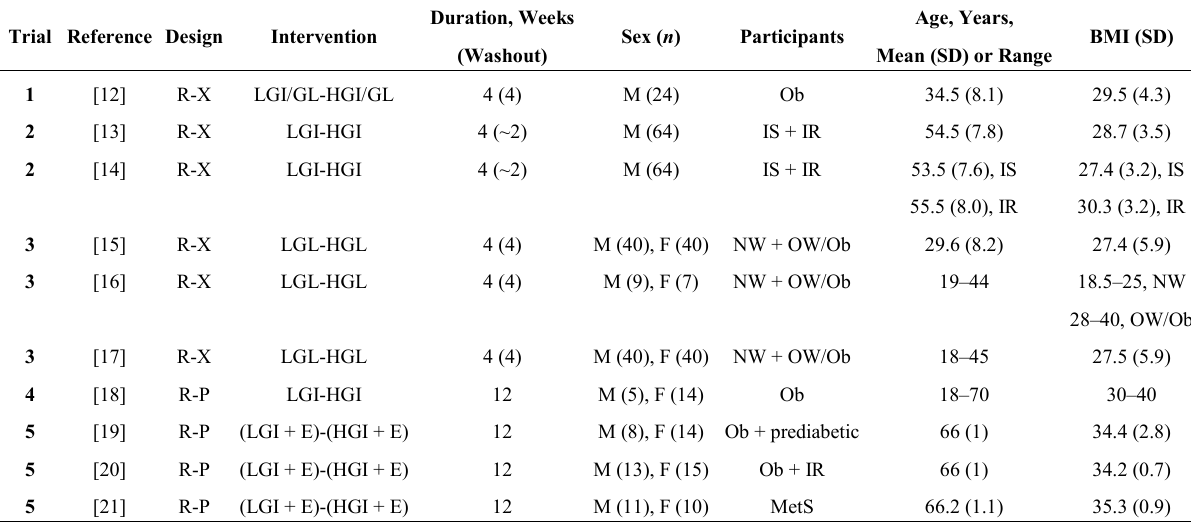
Table 1. Summary of study design and participant characteristics.